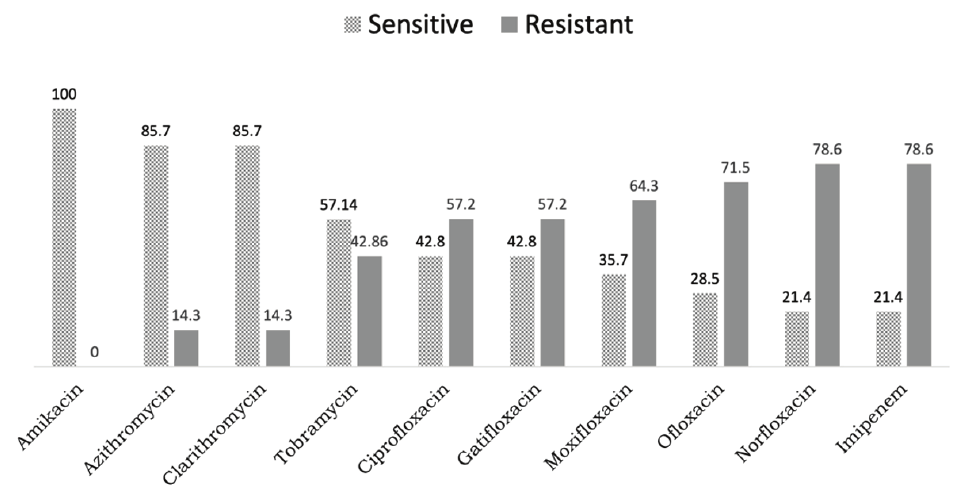
Figure 4. Bar diagram showing the sensitivity and resistance pattern of in vitro antibiotic susceptibility pattern of NTM isolates ( M. abscessus ) included in the study ( n =